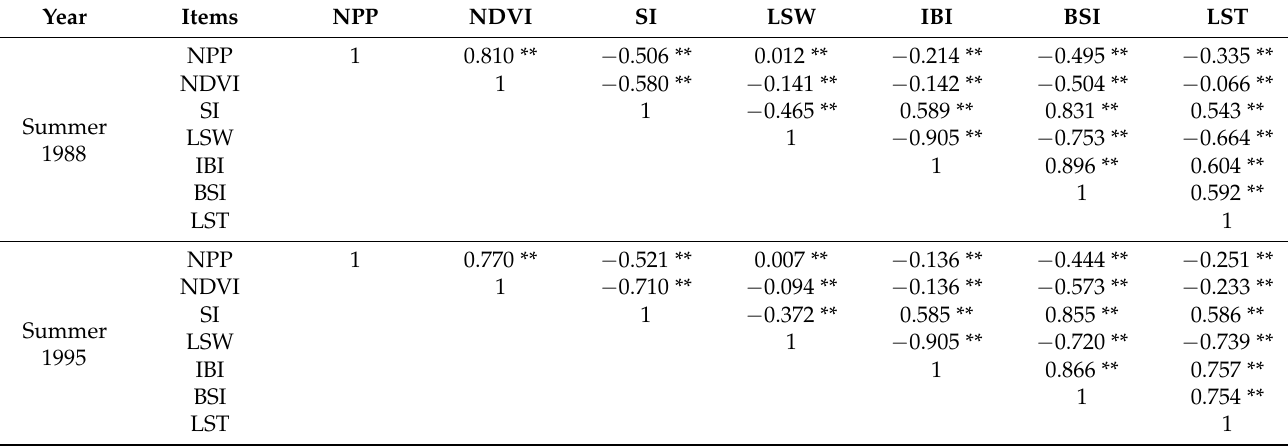
Table 5. Correlations between NPP, NDVI, SI, LSW, IBI, BSI, and